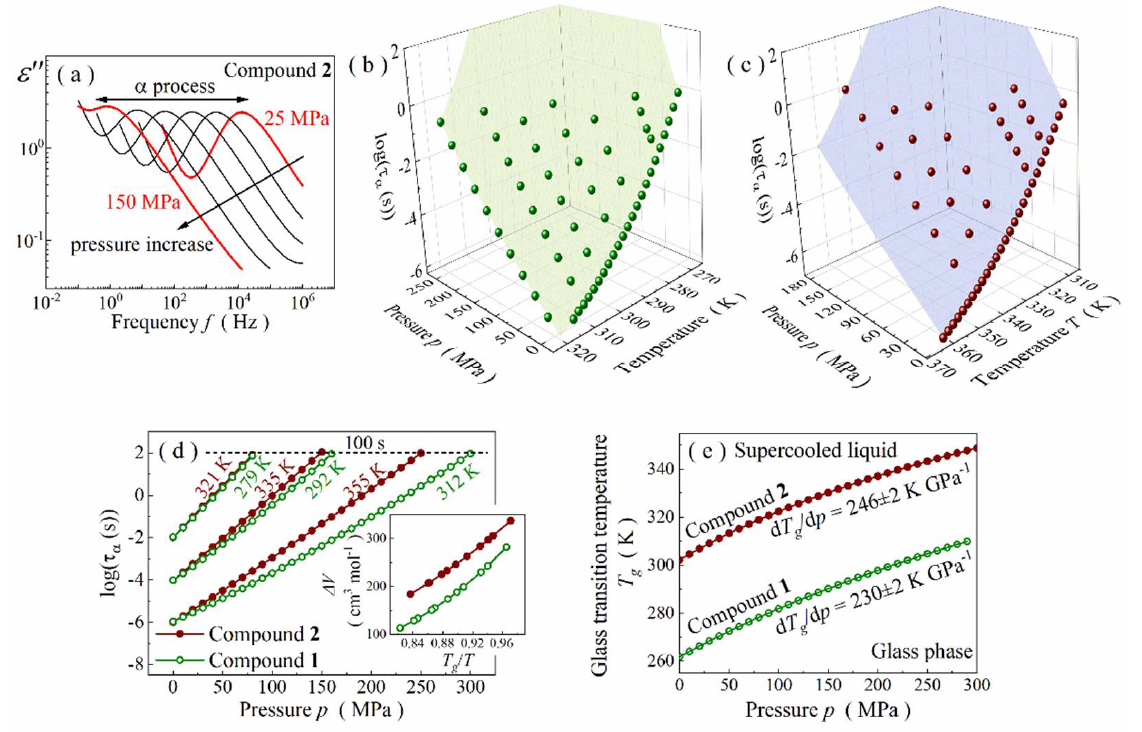
Figure 4. ( a ) Representative spectra measured at isothermal conditions of 351 K for compound 2 . ( b ) Pressure-temperature surface of τ α for compound 1 . ( c ) Pressure-temperature dependence of τ α for compound 2 . ( d ) Comparison of pressure-induced changes in relaxation times between compounds 1 and 2 . Insets show temperature variation of their activation volume values. ( e ) Phase diagram for compounds 1 and 2 .